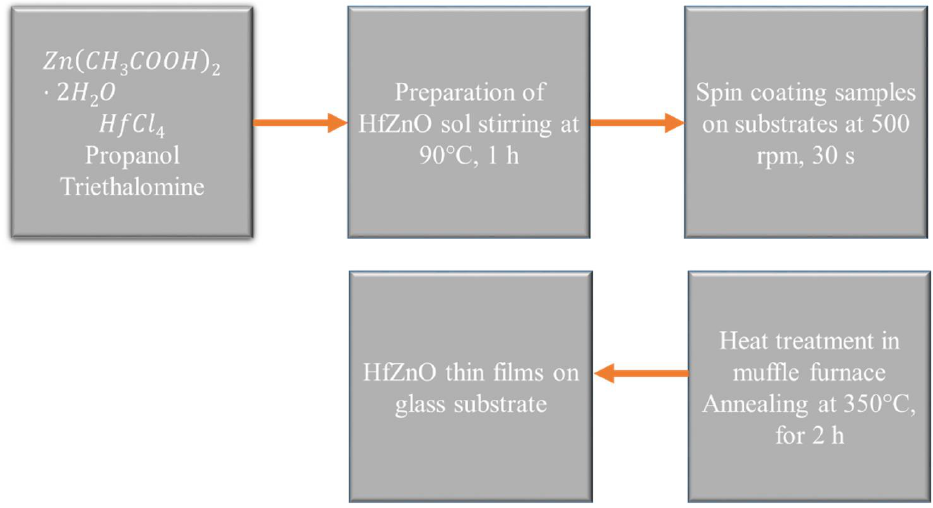
Figure 1. Schematic illustration of involved steps for synthesis of hafnium-doped ZnO.